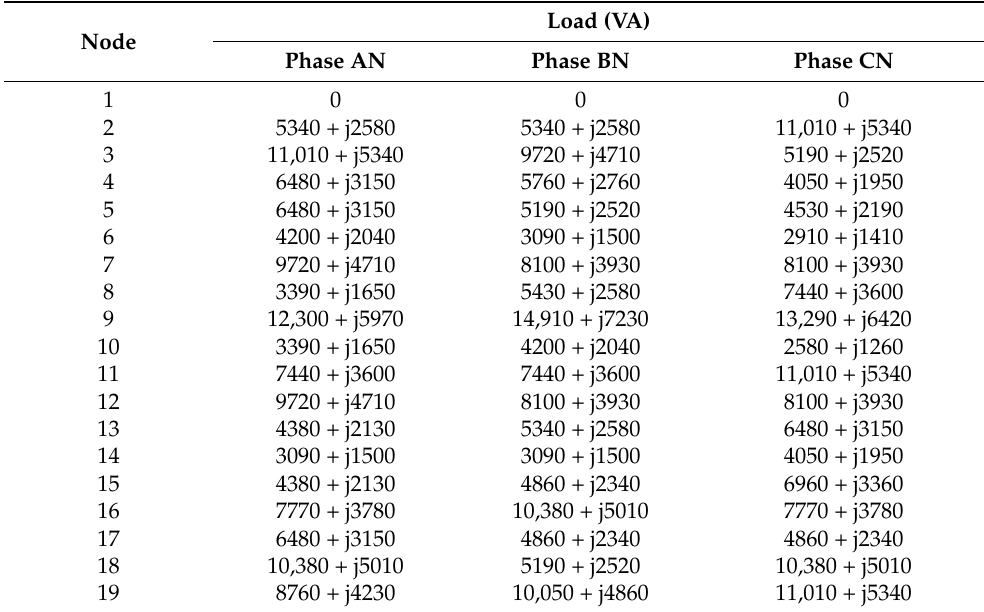
Table A6. Load of each